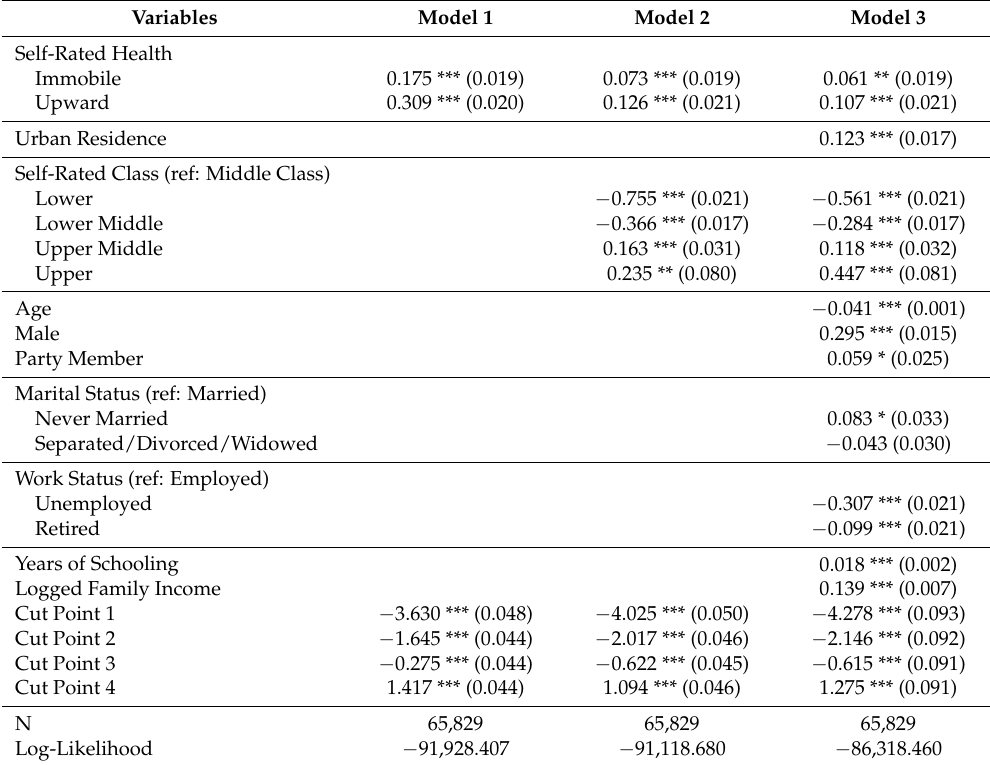
Table 3. Ordered Logit Model Predicting Self-Rated Health